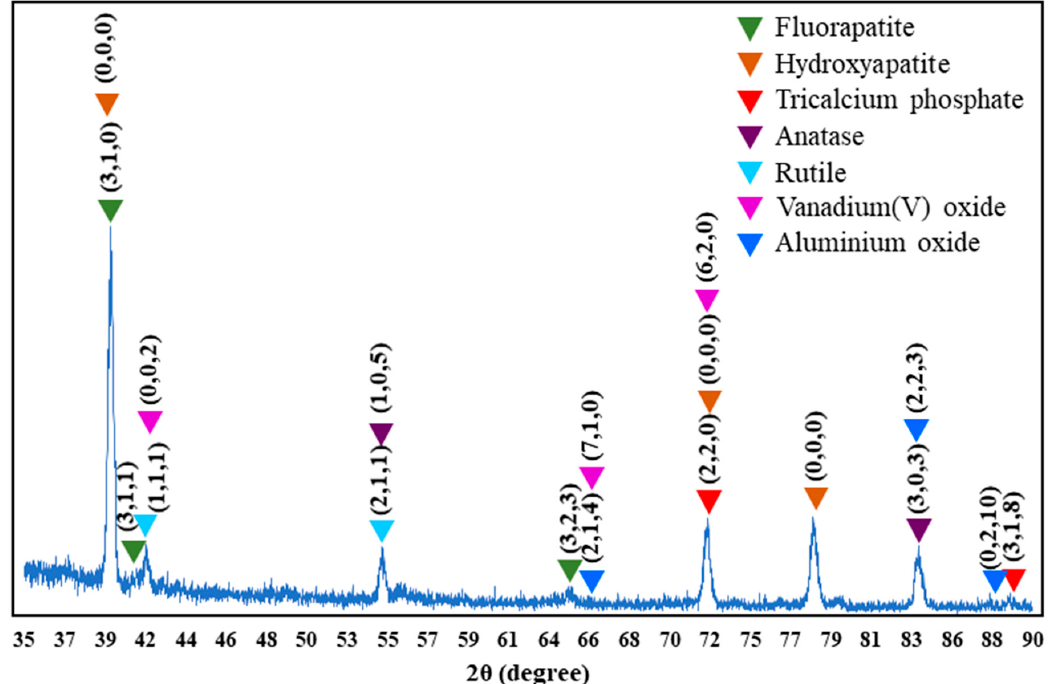
Figure 4. XRD pattern of the different phase compositions on the coating surface layer.